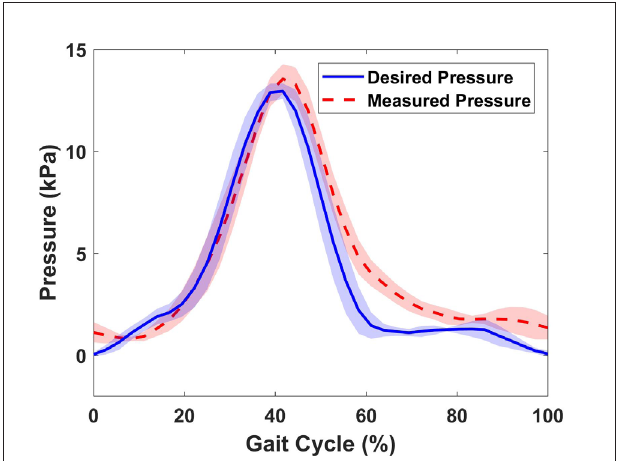
Figure 7 | Desired pressure calculated by algorithm ( kPa ) vs. Actual pressed measured by the pressure sensor ( kPa ) over five gait cycles with SD. (RMSE = 1.27 kPa and error = 8.46%)